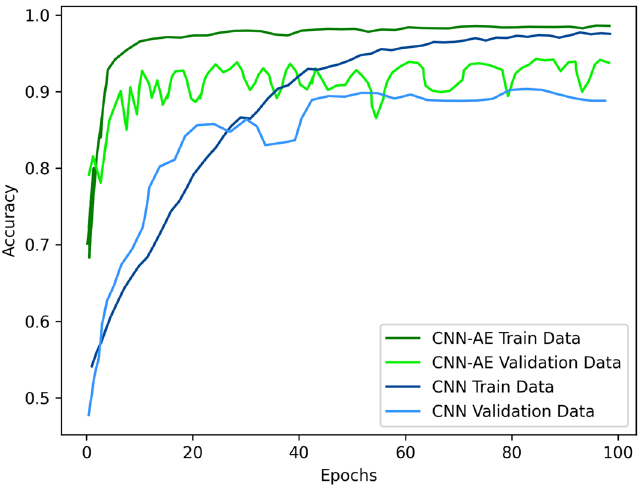
Figure 10. Accuracy plots of the CNN and CNN-AE methods during training of our dataset.